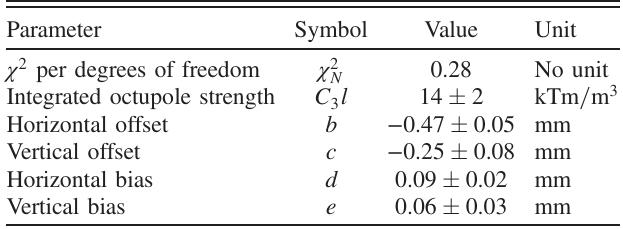
TABLE III. Fit results for position